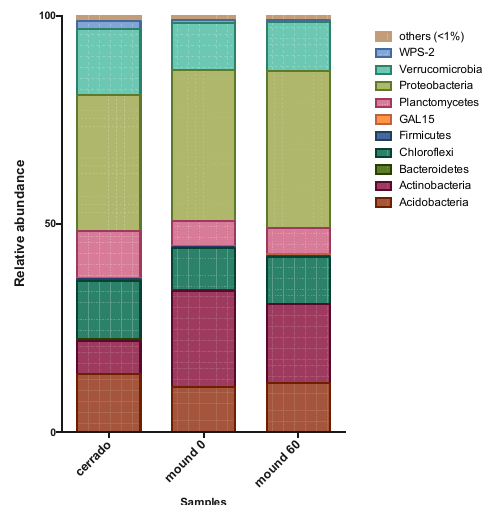
Figure 3. Microbial phyla profile of the dry season for the Cerrado (50–60 cm), mound surface (0–10 cm), and mound soil (50–60 cm) samples in 2017. The graph shows the relative abundance of the most abundant bacterial phyla. Values presented are the mean from the Cerrado, mound surface, and mound soil triplicates in the dry season.